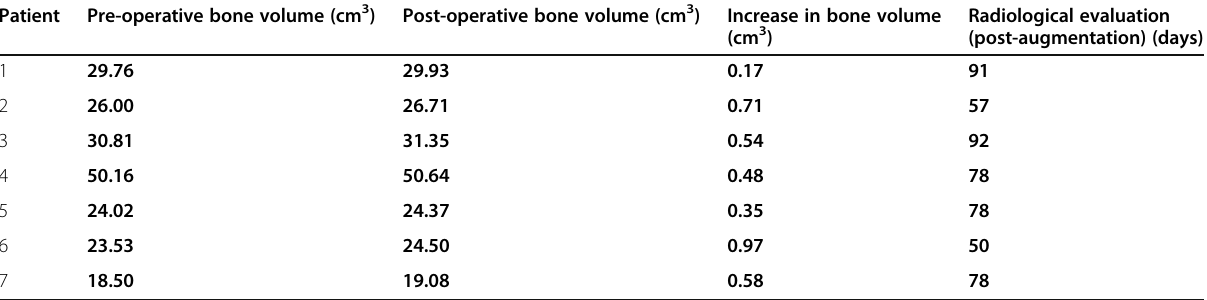
Table 1 Increase in bone volume